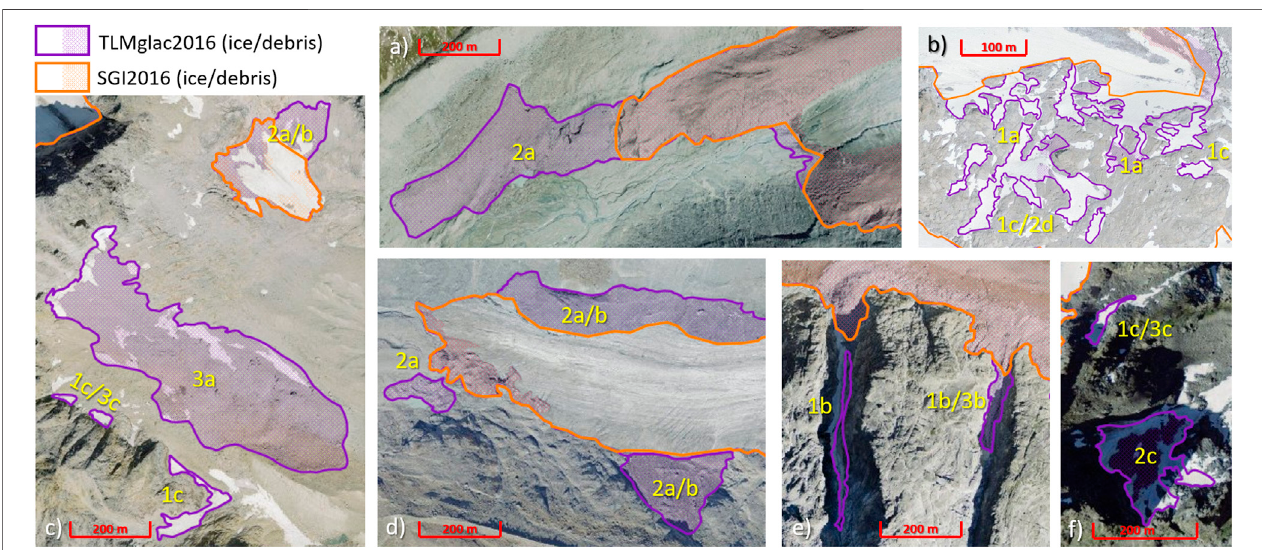
FIGURE 4 | Examples of features erroneously mapped as glacier in TLMglac. The numbers and letters indicate the reason according to Table 1 why the purple features (TLMglac) have been removed for the creation of the SGI2016 (orange outlines). A list with links to zoom in at swisstopo ’ s map browser and investigate the details more closely and in a broader context is available in Supplementary Table S2 .